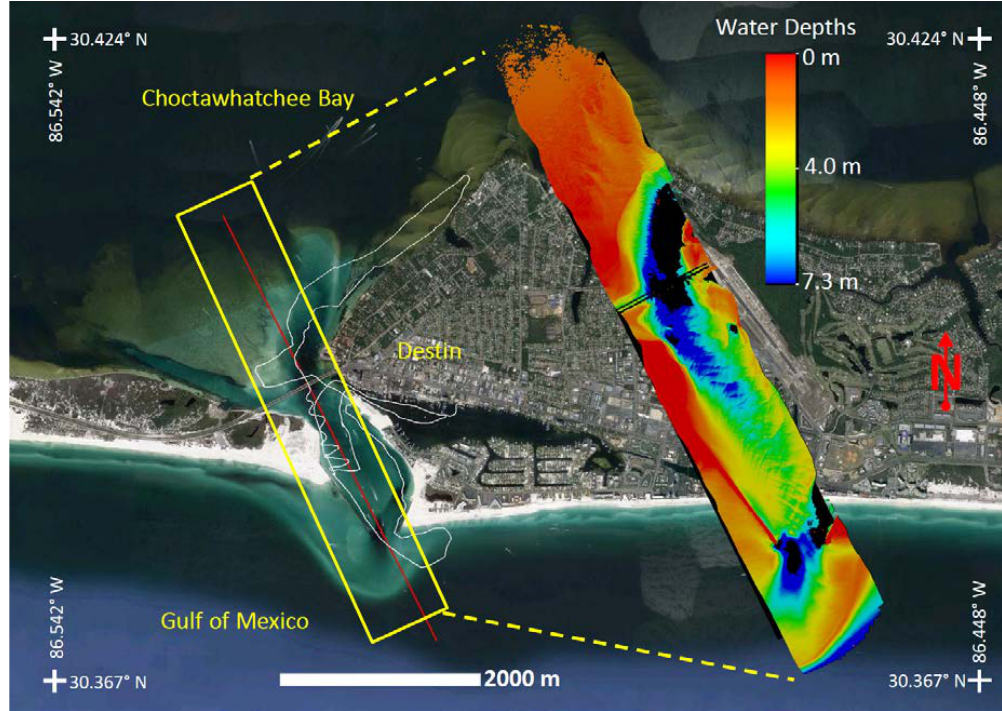
Figure 8. Illustration of the bathymetric test area: the East Pass near Destin, FL, USA. The solid red line represents the test line that was flown multiple times with different configurations. The white solid line represents the track of the validation samples obtained with an acoustic Doppler current profiler. The yellow rectangle represents the coverage of one the acquired test lines, and the bathymetric elevations derived from that test line dataset are presented as a color map that is offset to the east of the